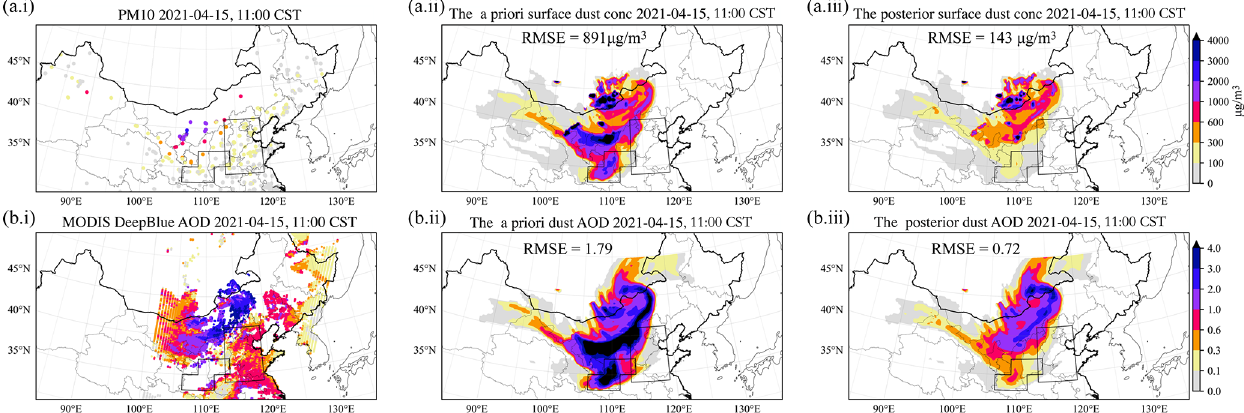
Figure 4. Snapshots of observations and simulations during severe dust event 3 (SD3) at 15 April 2021. Row (a) shows PM 10 concentrations observed by ground network at 11:00CST (i) , a priori (ii) , and posterior (iii) simulations by the LOTOS-EUROS/dust model. Row (b) shows for the same hour AOD at 550nm from MODIS Deep Blue observations (i) and simulations (ii–iii)